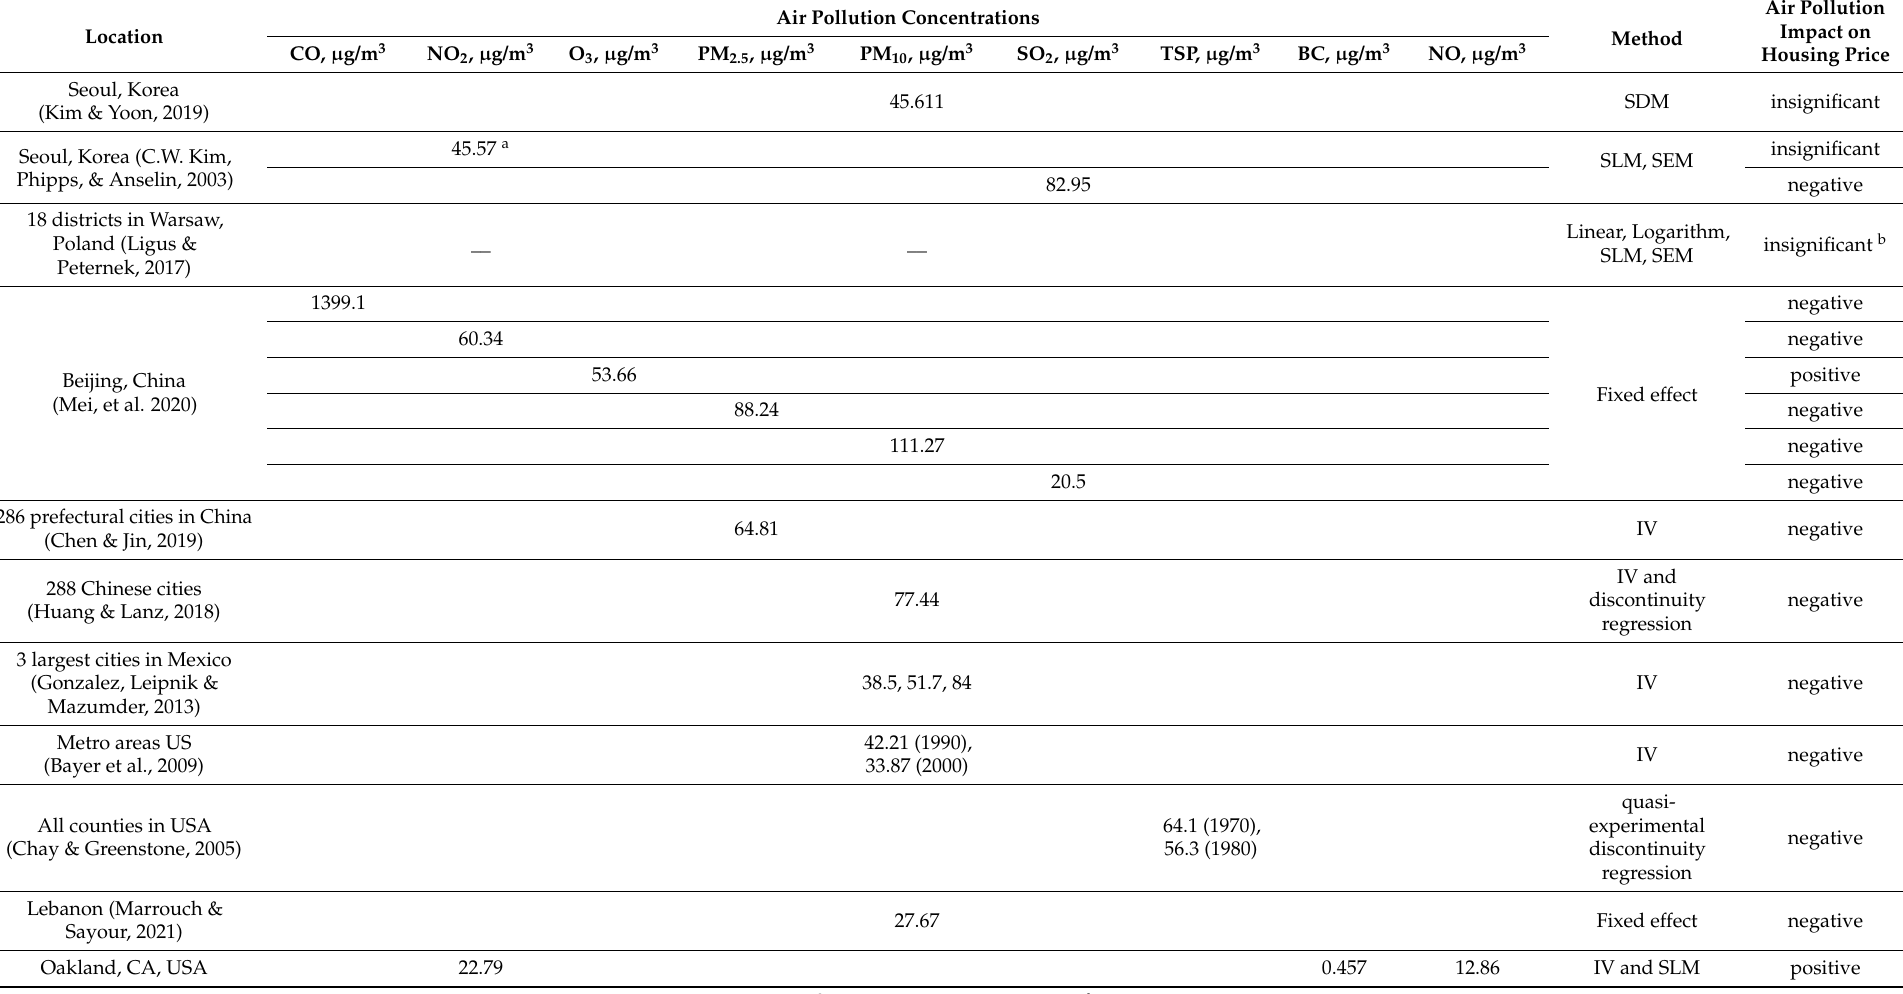
Table 4. Literature review